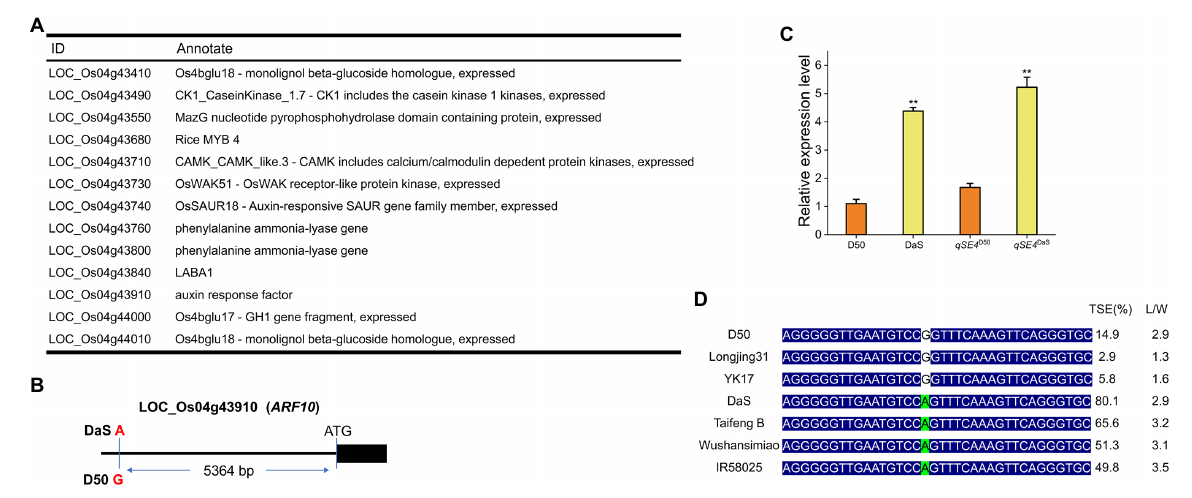
FIGURE 4 Identification of candidate genes for qSE4 . (A) Thirteen candidate genes for qSE4 (http://rice.plantbiology.msu.edu/, MSU- version_7.0). (B) At 5364 bp upstream of the ATG initiation codon of the gene ARF10 , there was one base different between the two parental DaS and D50, DaS was A, and D50 was G. (C) Relative expression of ARF10 in DaS, D50, RIL ( qSE4 D50 ) and RIL ( qSE4 DaS ). (D) The relationship between the haplotype in the 5,364 base upstream of ATG and stigma exsertion phenotype in different rice varieties. TSE: total stigma exsertion rate; L/W: length/width. The data represent the mean values ± SD ( n = 6), ** p ≤